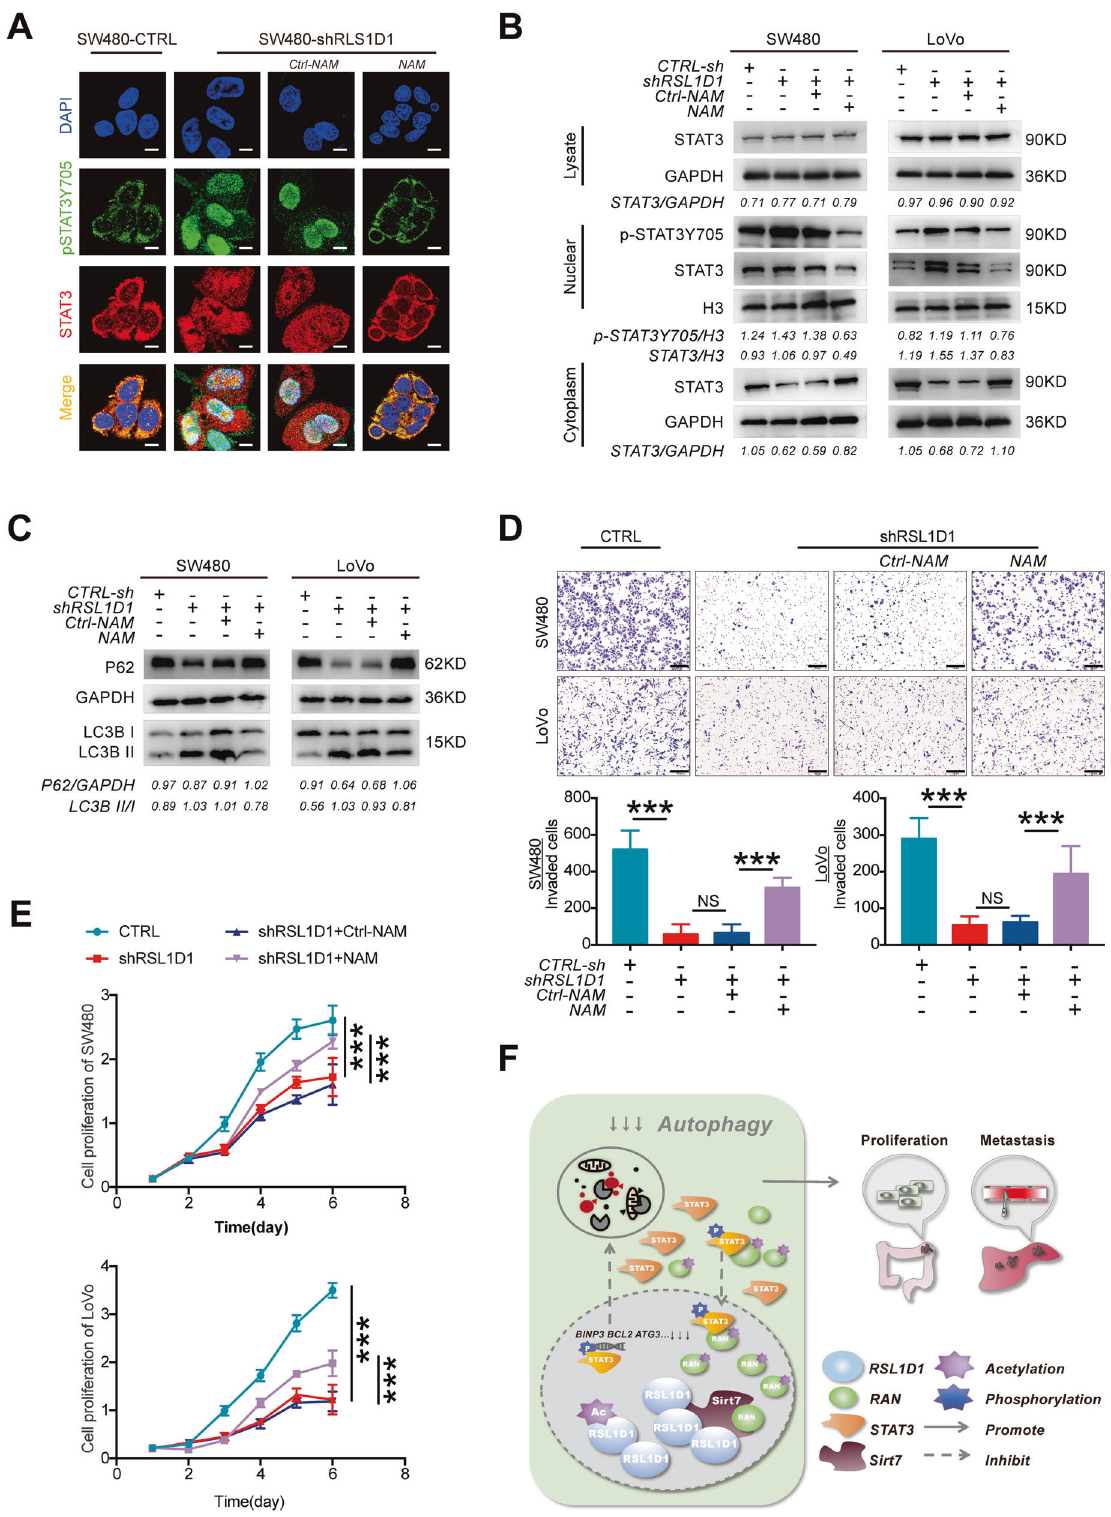
Fig. 8 RSL1D1 inhibits the deacetylation of RAN and then promotes CRC cell proliferation and invasion by suppressing STAT3-regulated autophagy. A IF analysis of STAT3 and p-STAT3 in CRC cells after RSL1D1 knockdown treated with NAM. Scale bar, 20 µm. B Total/nuclear/ cytoplasmic extraction and western blotting detected the expression of STAT3 and p-STAT3Y705 in CRC cells after RSL1D1 knockdown and treatment with NAM. C Protein expression of LC3-II and P62 was examined by WB in CRC cells after RSL1D1 knockdown and treatment with NAM. D – E . CCK-8 [ D ] and Transwell invasion assays [ E ] were used to detect the proliferation and invasion of CRC cells after RSL1D1 knockdown and treatment with NAM. Scale bar, 100 µm. F Schematic representation of the function and potential mechanism of RSL1D1 in colorectal cancer. * P < 0.05, ** P < 0.01, *** P < 0.001, NS means no statistic difference. The error bars represent mean ±